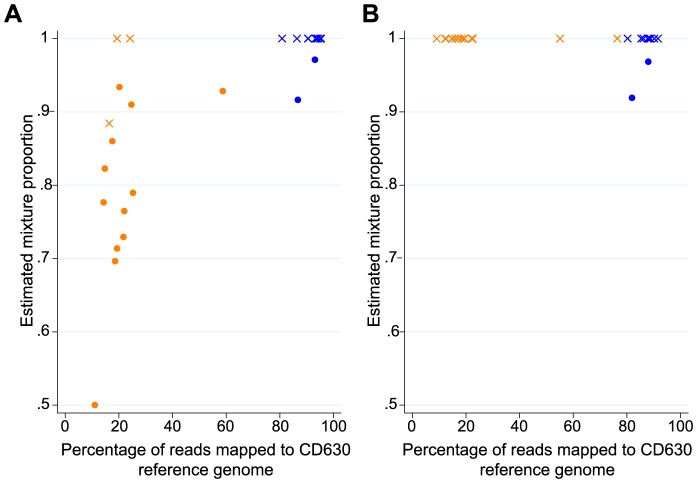
Reads mapped and estimated mixture proportion for possible mixed-ST clinical infections, across two alignment programs.Points in orange show evidence of contamination with other bacteria (i.e. <80% of reads mapped to reference genome), other points are shown in blue. Mixed infections detected using a −2 log likelihood ratio statistic threshold of ≥19.4 (as defined in the calibration samples) are shown as filled circles, other points are shown as crosses. Panel A shows the data obtained from alignments generated using Stampy. Stampy is designed to perform well with relatively high sequence variation relative to the reference, in particular insertions or deletions. In the more contaminated samples we observed markedly divergent reads from other species mapped to the highly conserved MLST loci resulting in falsely identifying mixed infections. Panel B show the data obtained from alignments generated with Burrows Wheeler Aligner. Two mixed infections were detected.